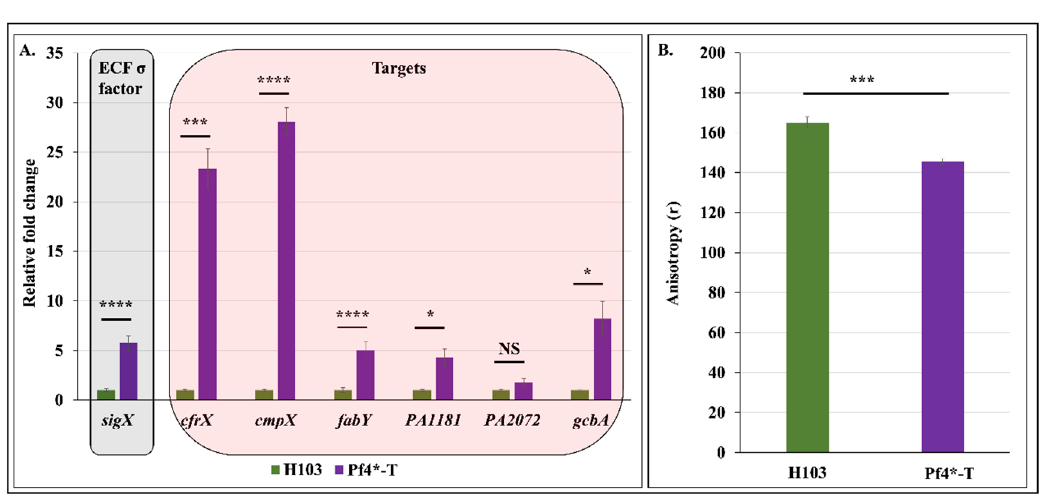
Figure 5. Pf4 phage variant infection triggers a strong SigX-mediated cell envelope stress response in H103 strain. ( A ). Relative mRNA expression levels of sigX , cfrX , cmpX , fabY, PA1181, PA2072 and gcbA in H103 (green bars) and Pf4*-T (violet bars) conditions as determined by RT-qPCR experiments. ( B ). Membrane fluidity assessment by fluorescence anisotropy using 1,6-diphenyl-1,3,5-hexatriene (DPH) probe in H103 (green bar) and Pf4*-T (violet bar) conditions. Each experiment was assayed at least four times independently. Statistics were achieved by paired (two samples) two-tailed t -test. NS p > 0.05; * p < 0.05; *** p < 0.001; **** p < 0.0001.